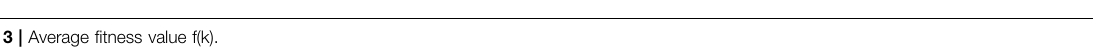
TABLE 3 | Average fi tness value f(k).